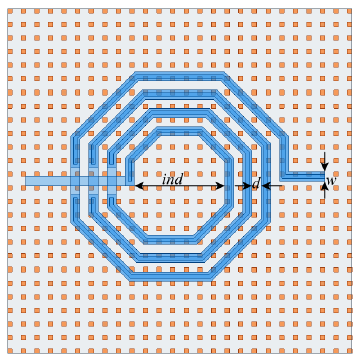
Figure 5. Top view of an inductor containing DMFs.